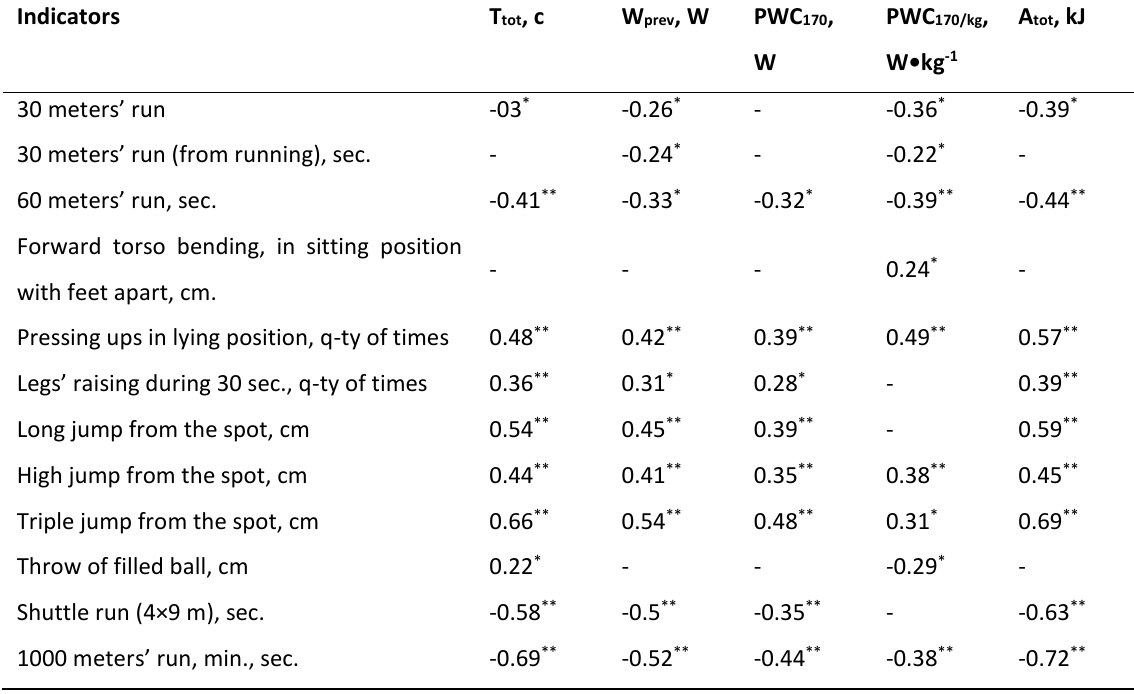
Table 3. Correlation between physical workability and physical fitness indicators of 17-19 years’ age students